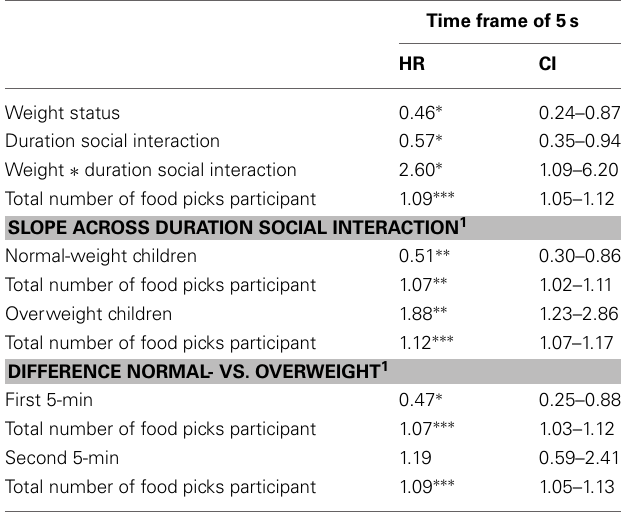
Table 3 | Likelihood of imitation of normal-weight vs. overweight children controlled for total number of times participants picked